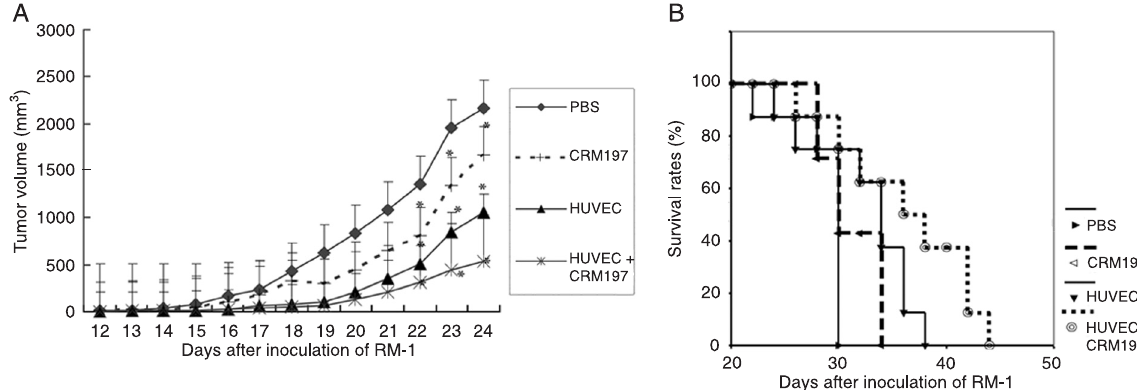
Figure 1. Tumor growth and survival rates in the preventive procedure. A , Vaccination with viable HUVECs mixed with CRM197 fur- ther retarded tumor growth in the preventive process. C57BL/6J mice were immunized with viable HUVECs, HUVECs combined with CRM197, CRM197, or PBS weekly for four consecutive weeks. Then, they were challenged with 5 x 10 5 RM-1 cells (N = 8). Tumor volumes were monitored until death occurred. The difference in tumor volume was significantly different between the four groups on days 22, 23, and 24 (P < 0.05, Student t -test). Data are reported as means ± SD. B , Viable HUVECs combined with CRM197- immunized mice survived significantly longer than mice in the other three groups. HUVECs = human umbilical vein endothelial cells; CRM197 = nontoxic diphtheria toxin.